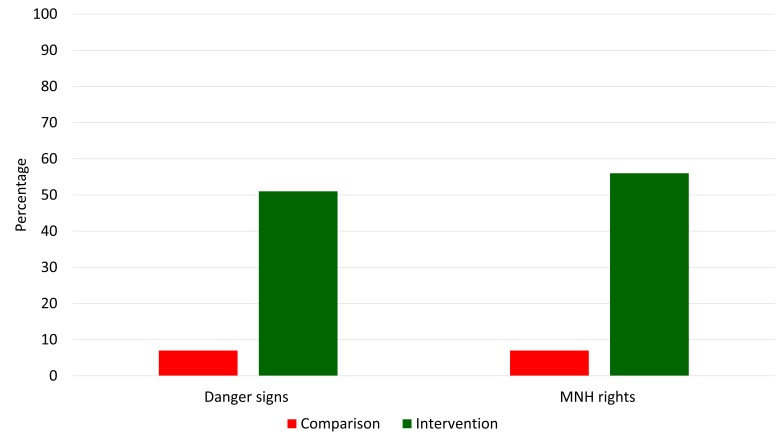
Courtyard meetings mentioned as a source of knowledge and information among women at endline.